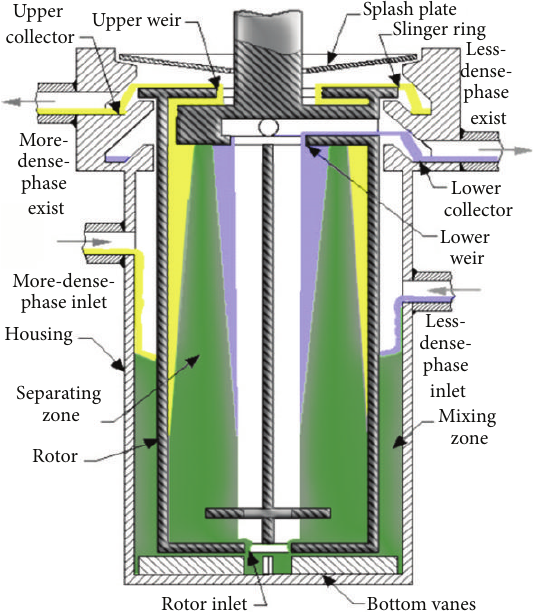
Figure 1: Sketch of an annular centrifugal